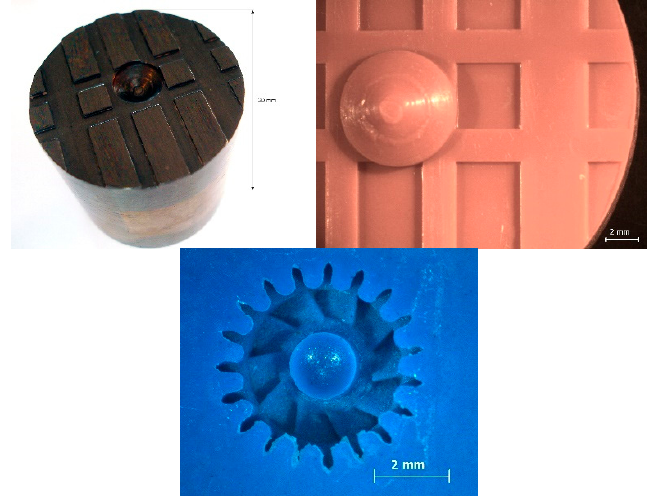
Figure 5. Images of molds used in powder hot embossing.